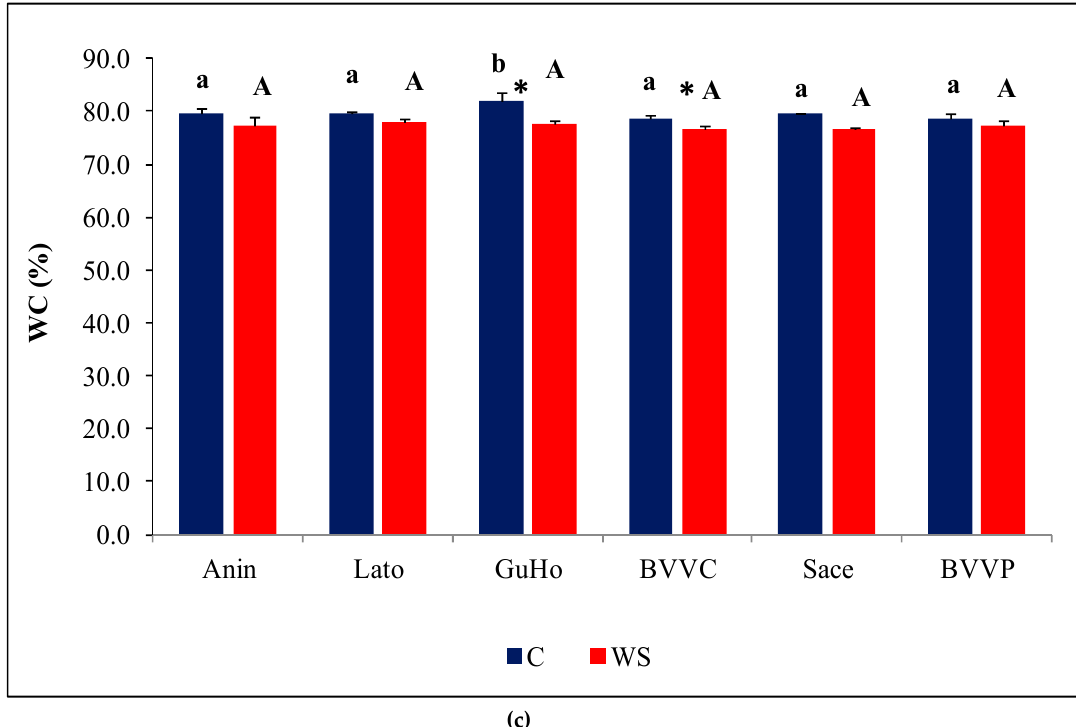
Figure 3. Growth parameters of six Romanian provenances of L. decidua after one month of applied drought stress (Mean ± SE, n = 5): ( a ) Stem length elongation (cm); ( b ) Needles fresh weight (mg); ( c ) Needles water content percentage (WC). Comparing provenances, different lowercase letters indicate significant differences between control plants, and different uppercase letters indicate significant differences between drought-affected plants, according to Tukey’s test ( α = 0.05). Asterisks indicate a significant difference between treatments within the same provenance, according to the LSD value for the interaction ( p = 0.05).